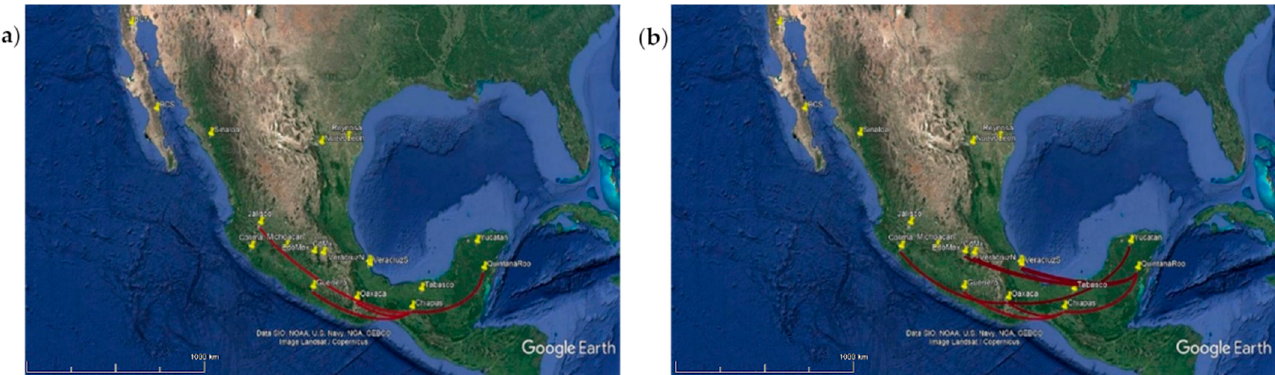
Figure 3. Spatiotemporal circulation of CHIKV during the outbreak 2014–2016 in Mexico repre- sented with snapshots of the dispersal pattern for ( a ) December 2014, ( b ) June 2015, ( c ) December 2015 and ( d ) September 2016. Lines represent MCC phylogeny branches projected on the surface. 4. Discussion Previous studies on the molecular diversification of CHIKV in Mexico were restricted to limited geographic regions of the country, such as Chiapas [25] and Tamaulipas [27]. Herein we extended these studies with samples collected across Mexico.